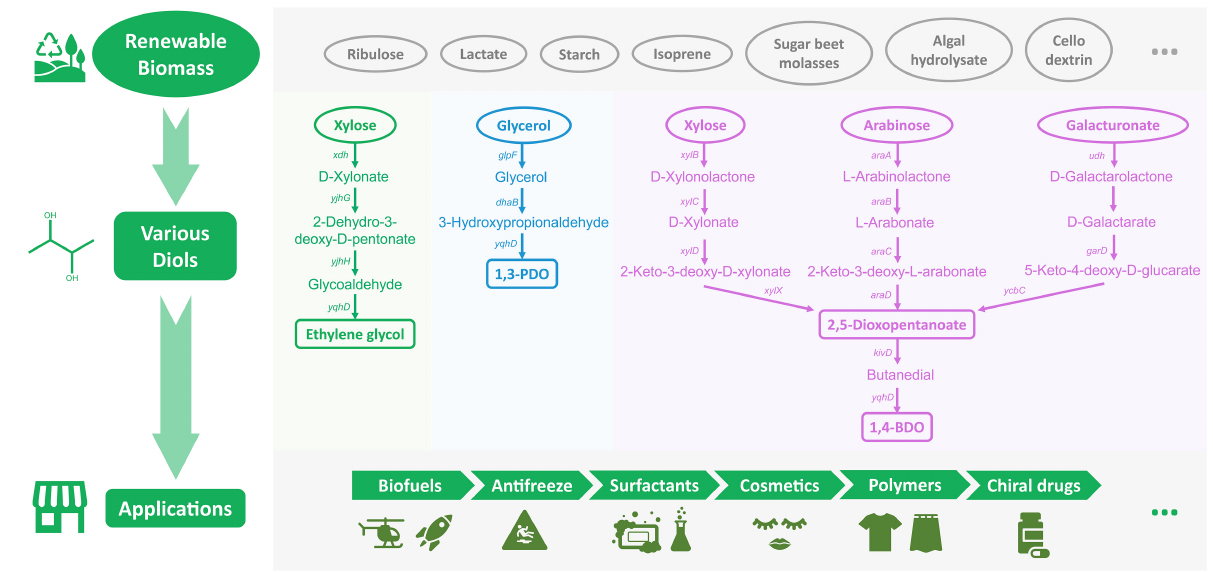
Figure 2. Biosynthetic pathways of diols from other carbon sources in E. coli . The green areas repre- sent EG biosynthesis from xylose, the blue areas represent the biosynthetic pathway of 1,3-PDO from glycerol, and the purple areas represent the metabolic pathway of 1,4-BDO from other carbon sources. The gray areas represent the carbon sources for diol biosynthesis, and the applications of diols, re- spectively. xdh : D -xylose dehydrogenase; yjhG : D -xylonate dehydratase; yjhH : 2-dehydro-3-deoxy-d- xylonate aldolase; yqhD : alcohol dehydrogenase; glpF : glycerol facilitator; dhaB : glycerol dehydratase; xylB : D -xylose dehydrogenase; xylC : D -xylonate dehydratase; xylD : 2-dehydro-3-deoxy-d-xylonate dehydratase; xylX : α -ketoglutaric semialdehyde dehydrogenase; araA : L -arabinose dehydrogenase; araB : L -arabinolactonase; araC : L -arabonate dehydratase; araD : α -keto-3-deoxy- L -arabonate dehy- dratase; kivD : α -keto acid decarboxylase; udh : uronate dehydrogenase; garD : D -galactarate dehy- dratase; ycbC : 5-keto-4-deoxy- D -glucarate